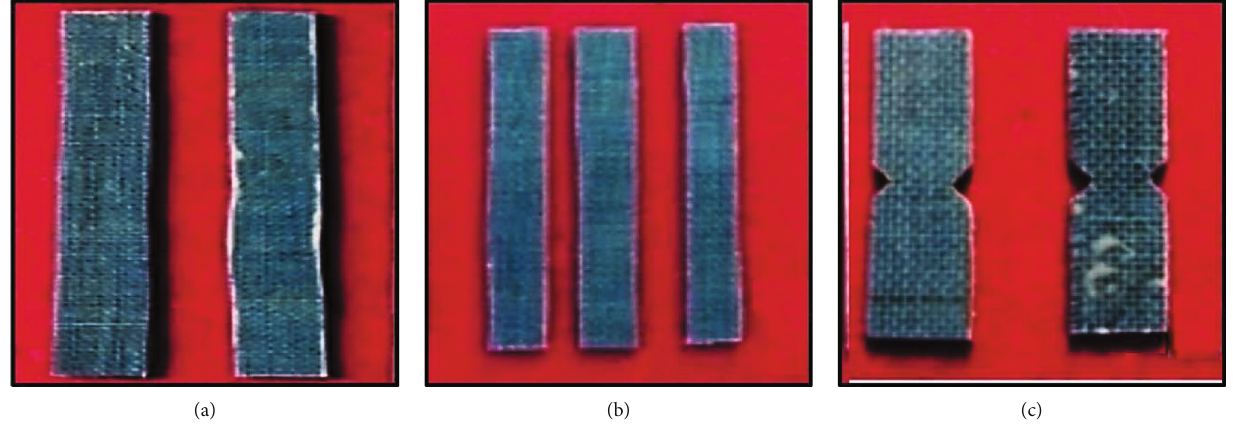
Figure 4: Specimen size of (a) tensile, (b) fl exural, and (c) impact